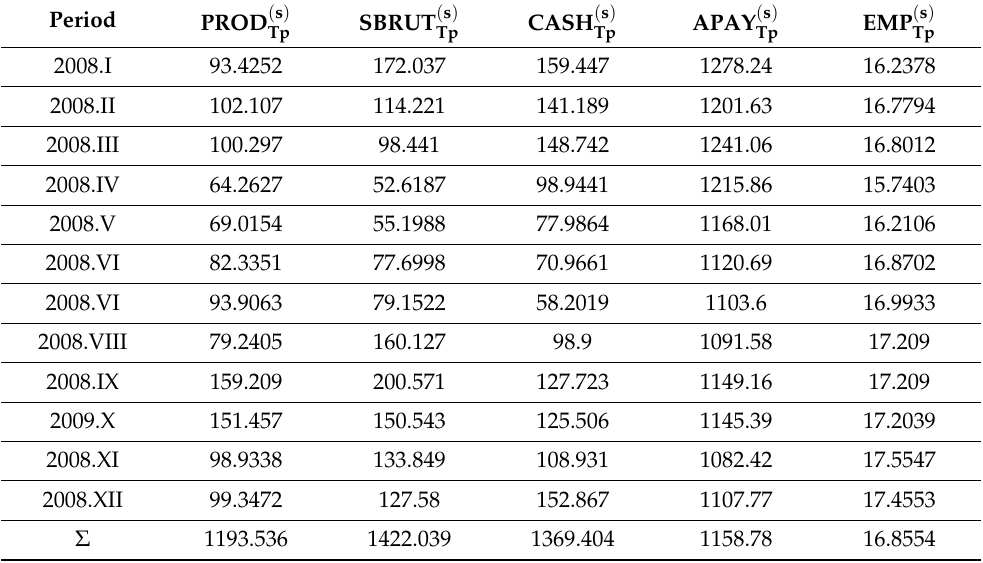
Table 2. Monthly synchronized forecasts of the variables forming the cycle under the conditions of a stabilized initial value of machinery and equipment in 2008.